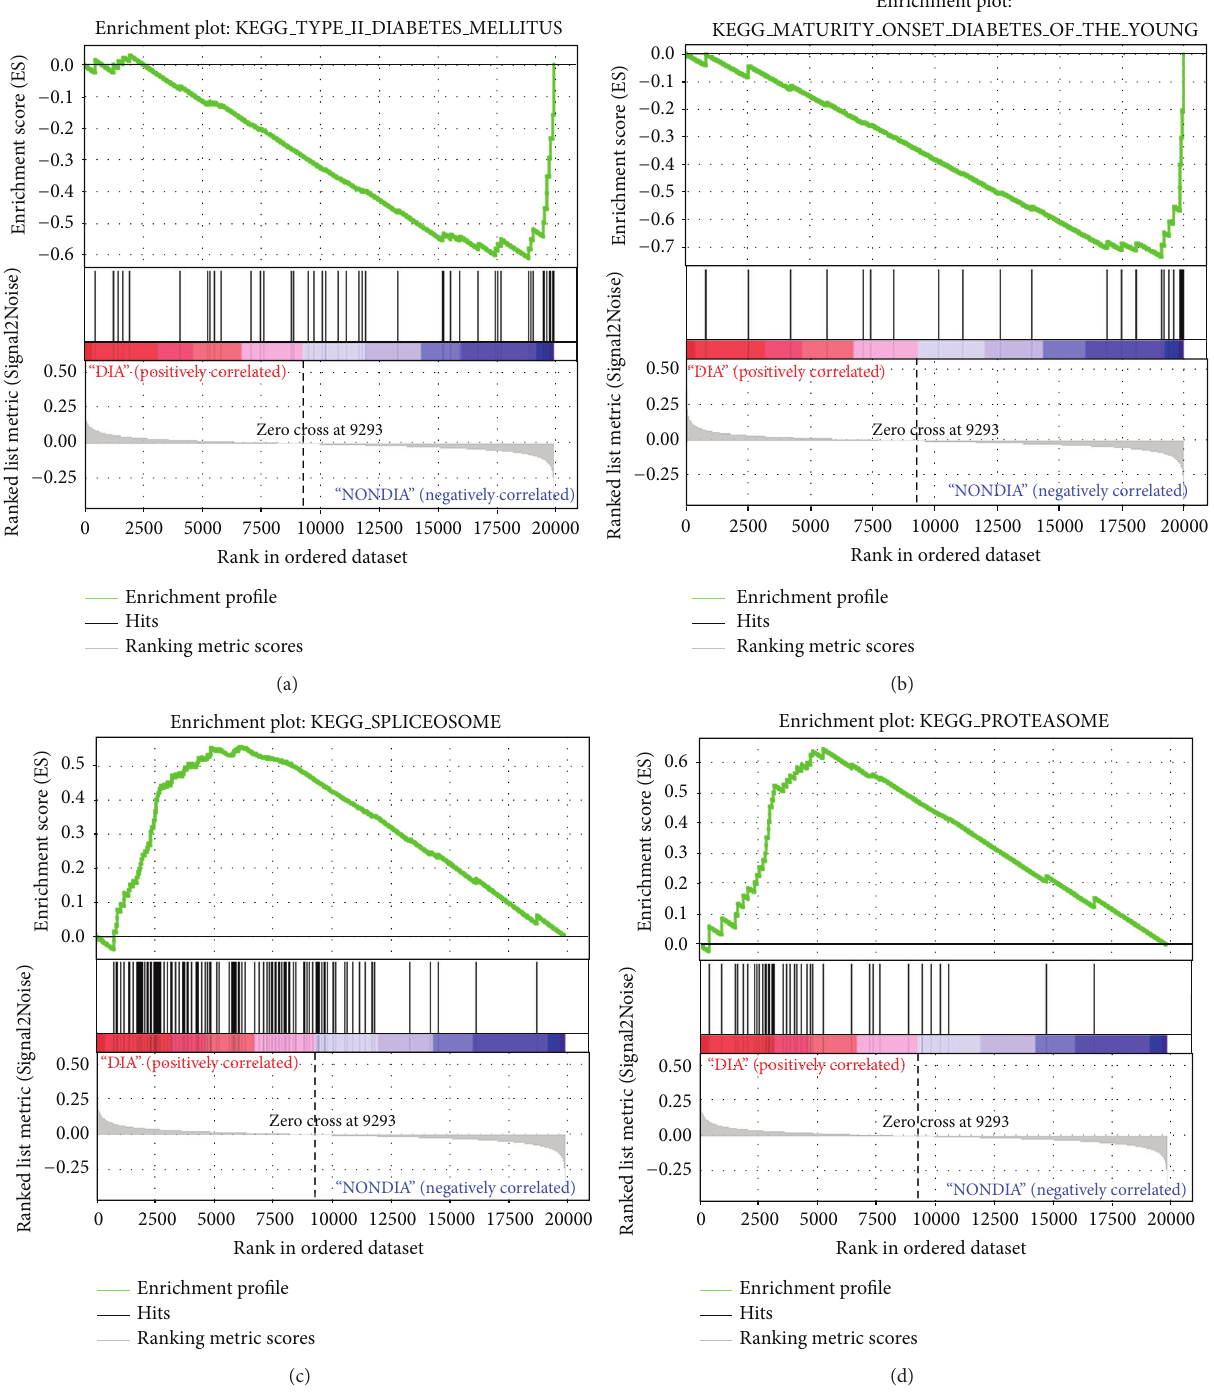
Figure 1: GSEA plot. The analysis was performed against the KEGG database for differential enriched pathways between hyperglycemic and normoglycemic islets. Enrichment plots for the downregulated pathways are shown in graphs (a) and (b) and upregulated pathways are shown in graphs (b) and (c). The 𝑦 -axis represents the value of the ranking metric; the 𝑥 -axis represents the rank for all genes. Bottom: plot of the ranked list of all genes. Top: the enrichment score for the gene set as the analysis walks along the ranked list. The score at the peak of the plot is the enrichment score (ES) for this gene set and those genes appearing before or at the peak are defined as core enrichment genes in this gene set. Lower levels of expression are represented in shades of blue and higher expression is represented in